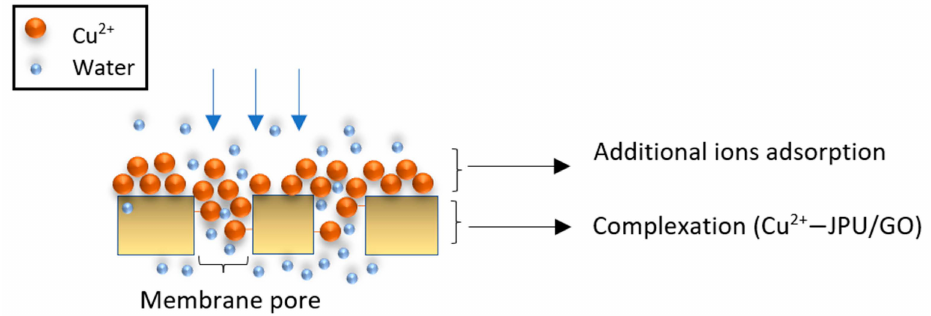
Figure 4. Schematic representation of JPU/GO 0.50 wt% membrane active layer during